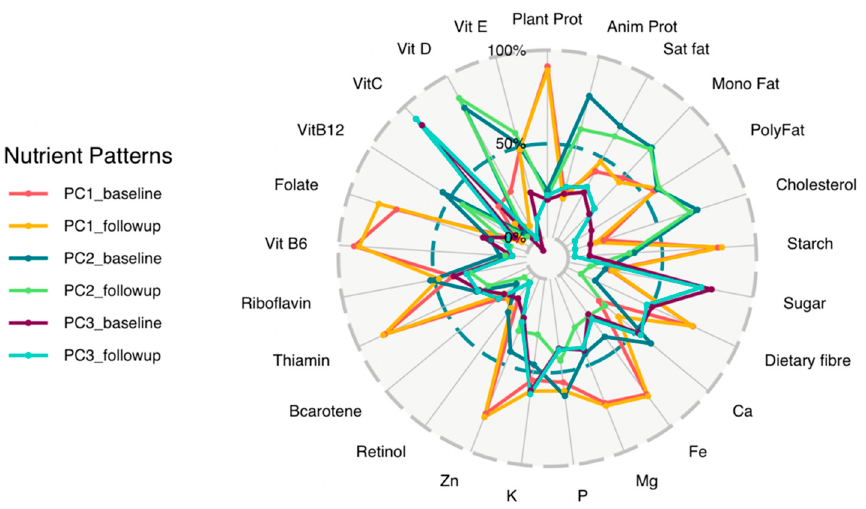
Figure 2. Baseline and follow-up PC derived nutrient patterns. This is based on 25 nutrient items in middle-aged black South African women ( n = 132). Identified by principle component analysis, on the circular plot, the first 3 PCs that met the Scree test which was used to determine the number of PCs to retain and eigenvalues are shown by different coloured lines (referred to as PCA nutrient pattern 1–3) for both baseline and follow-up and each component represents an independent nutrient pattern. PC = principal component; Plant Prot = plant protein; Anim prot = animal protein; Sat fat = saturated fat; Mono Fat = monounsaturated fat; Poly Fat = polyunsaturated fat; Ca = Calcium; Fe = Iron; Mg = magnesium; P = phosphorus; K = potassium; Zn = zinc; Vit B6 = vitamin B6; Vit B12 = vitamin B12; Vit C = vitamin C; Vit D = vitamin D; Vit E = vitamin E; PC1 = plant driven nutrient pattern; PC2 = animal protein driven nutrient pattern; PC3 = vitamin C, sugar and potassium driven nutrient pattern. The orange and yellow line (PC1) represents the factor loadings related to the plant driven nutrient pattern (baseline and follow-up, respectively), the dark and light green lines (PC2) represents factor loadings related to the animal protein driven nutrient pattern (baseline and follow-up) and the purple and light blue lines (PC3) represents factor loadings related to the vitamin C, sugar and potassium driven nutrient pattern (baseline and follow ‐ up).